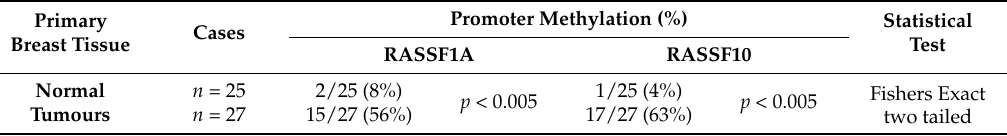
Table 1. Promoter methylation of RASSF1A and RASSF10 in primary breast